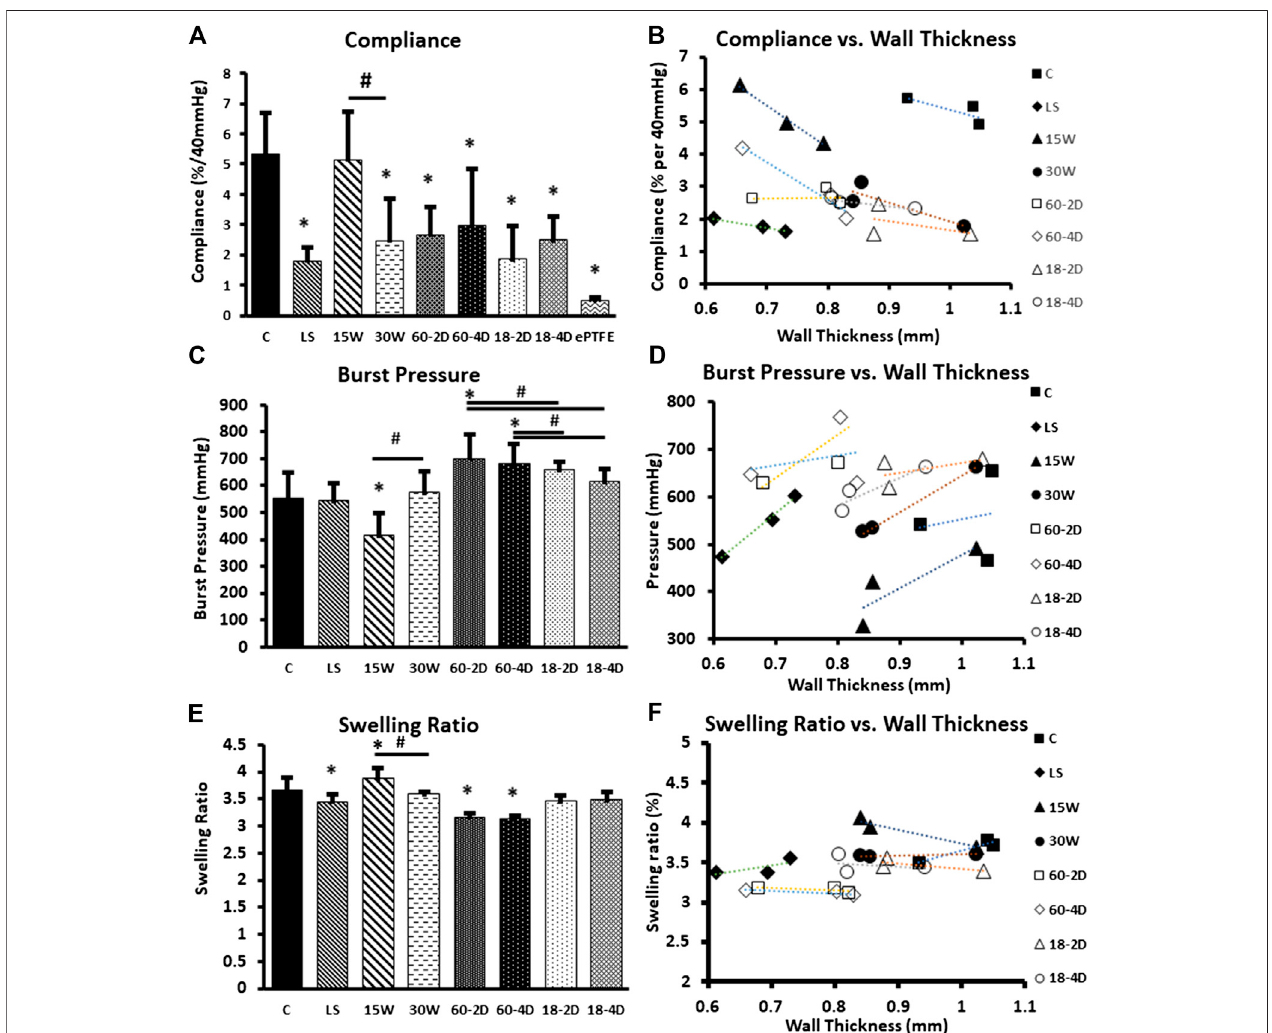
FIGURE 4 | Bulk properties of the samples. (A) Compliance of each group. (B) Compliance of each group plotted against their respective wall thickness. Average values of compliance and wall thickness of the internal replicates used to plot the graph. (C) Burst pressure of each group. (D) Burst pressure of each group plotted against their respective wall thickness. Average values of burst pressure and wall thickness of the internal replicates used to plot the graph. (E) Swelling ratio of each group, and (F) swelling ratio plotted with respect to the wall thickness of each group. *Indicates p ＜ 0.05 with respect to control group. # Indicates p ＜ 0.05 between the groups being compared. n (cid:2) 9 for all